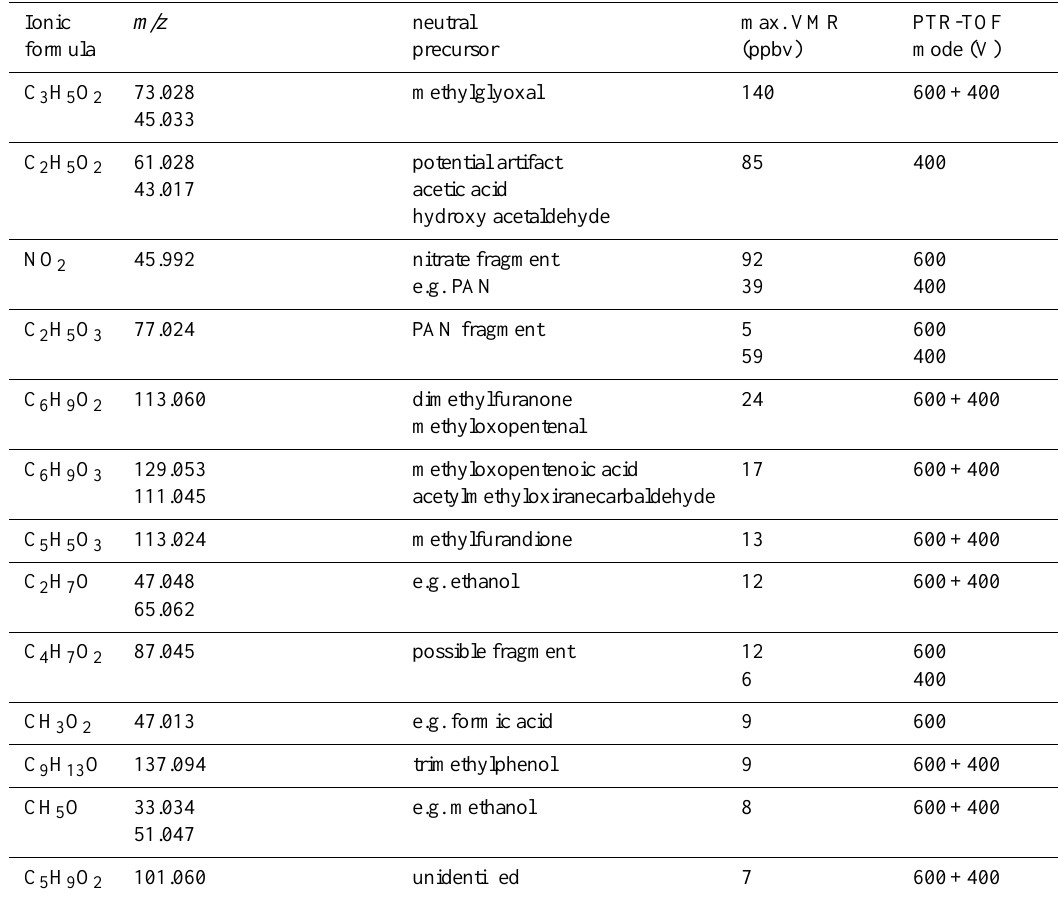
Table 3. List of ion sum formulas of the major TMB degradation products measured during experiments 1a and 1b within 7h of reaction. The measured maximum volume mixing ratio (max. VMR) is also